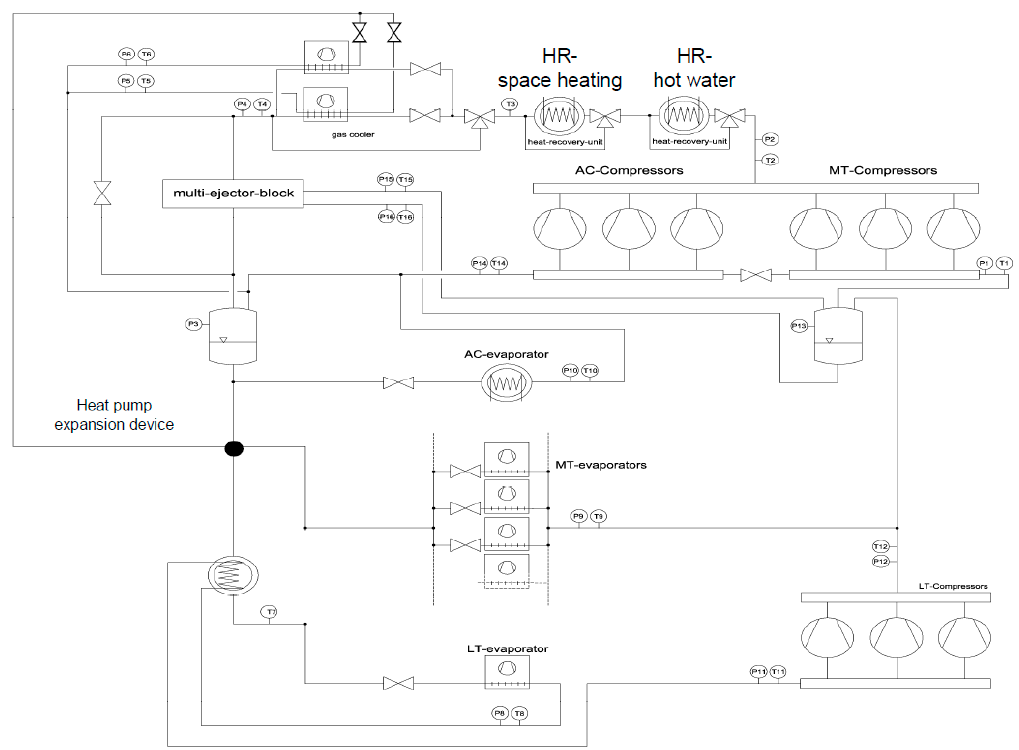
Figure 6. Fully-integrated R744 multi-ejector enhanced parallel compression system installed in a food retail store located in Spiazzo (Northern Italy) [21].